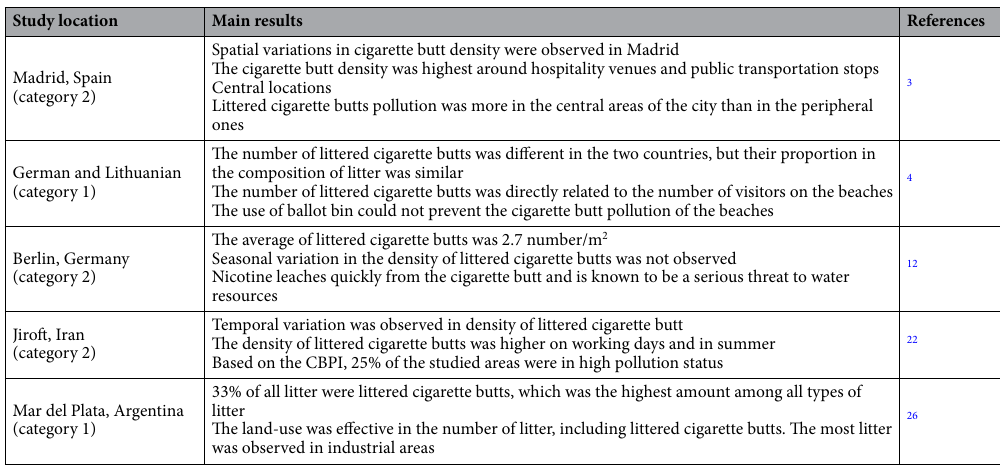
Table 4. Results of some research on litter and littered cigarette